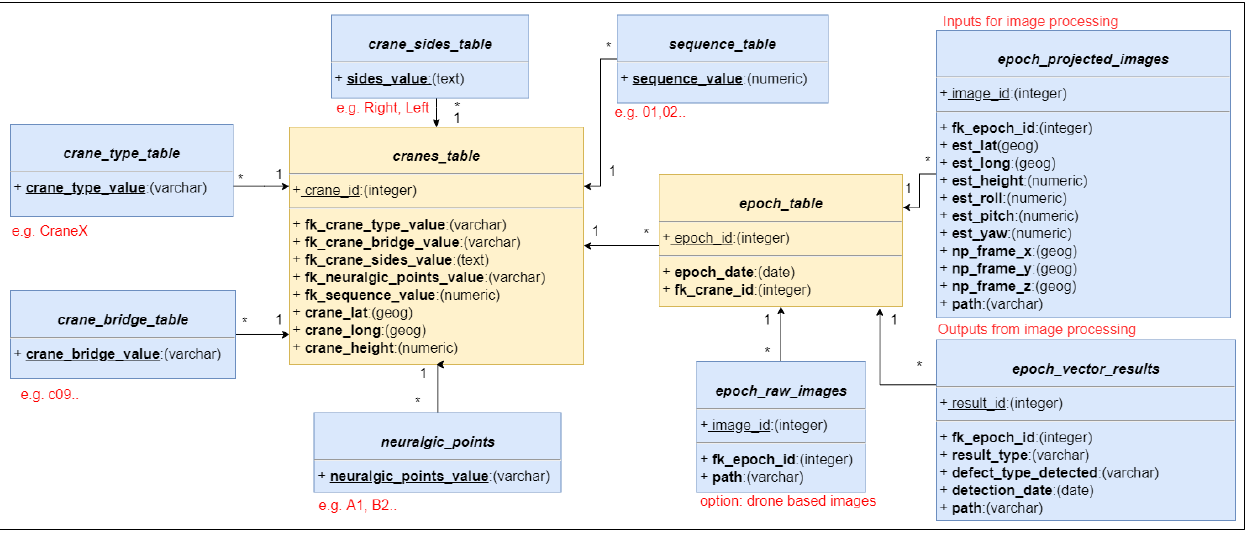
Figure 6 . Database schema/structure